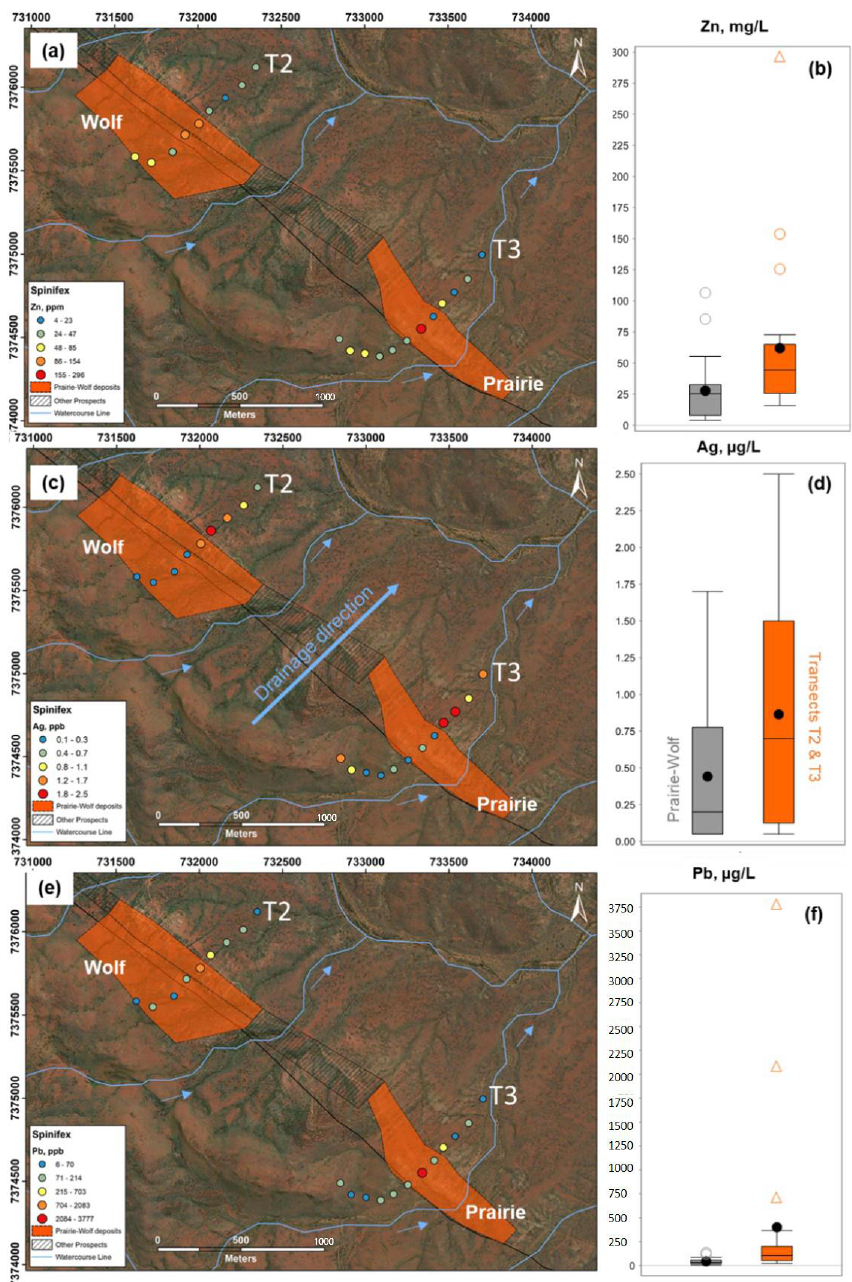
Figure 3. Metal concentrations in spinifex leaves along transects T2 (Wolf deposit) and T3 (Prairie deposit) and box plots of metal concentrations in spinifex leaves within the study area (grey boxes, n = 24) versus those along transects T2 and T3 (orange boxes, n = 21). ( a ) Spatial distribution of Zn concentrations in spinifex leaves along the Wolf and Prairie tran- sects. ( b ) Box plot of Zn (ppm) in spinifex leaves. ( c ) Spatial distribution of Ag (ppb) concentrations in spinifex leaves along the Wolf and Prairie transects. ( d ) Box plot of Ag in spinifex leaves. ( e ) Spatial distribution of Pb (ppb) concentrations in spinifex leaves along the Wolf and Prairie transects. ( f ) Box plot of Pb in spinifex leaves. Triangles in box plots indicate far outliers.